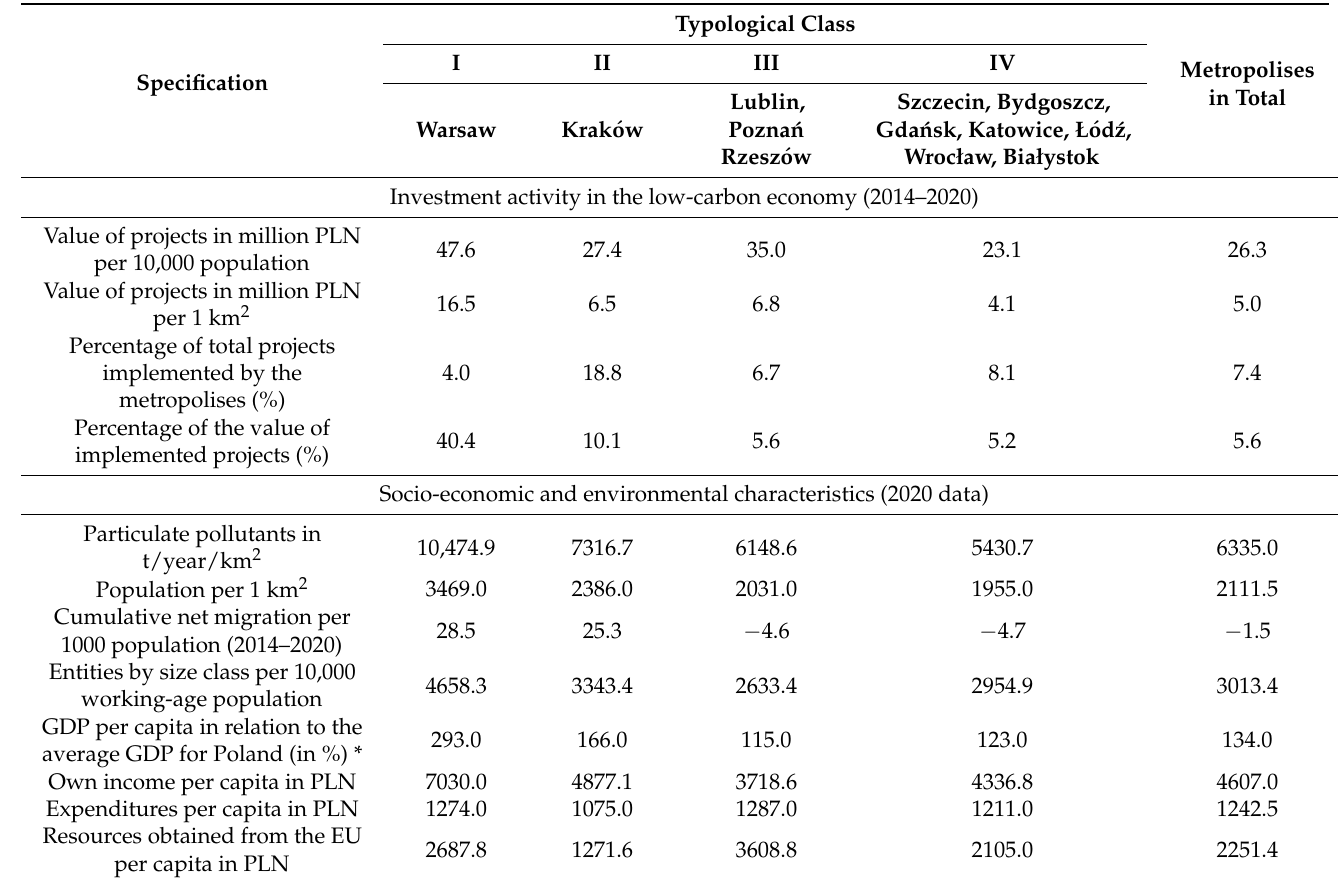
Table 3. Inter-group variation of metropolitan investment activity in the low-carbon economy co-